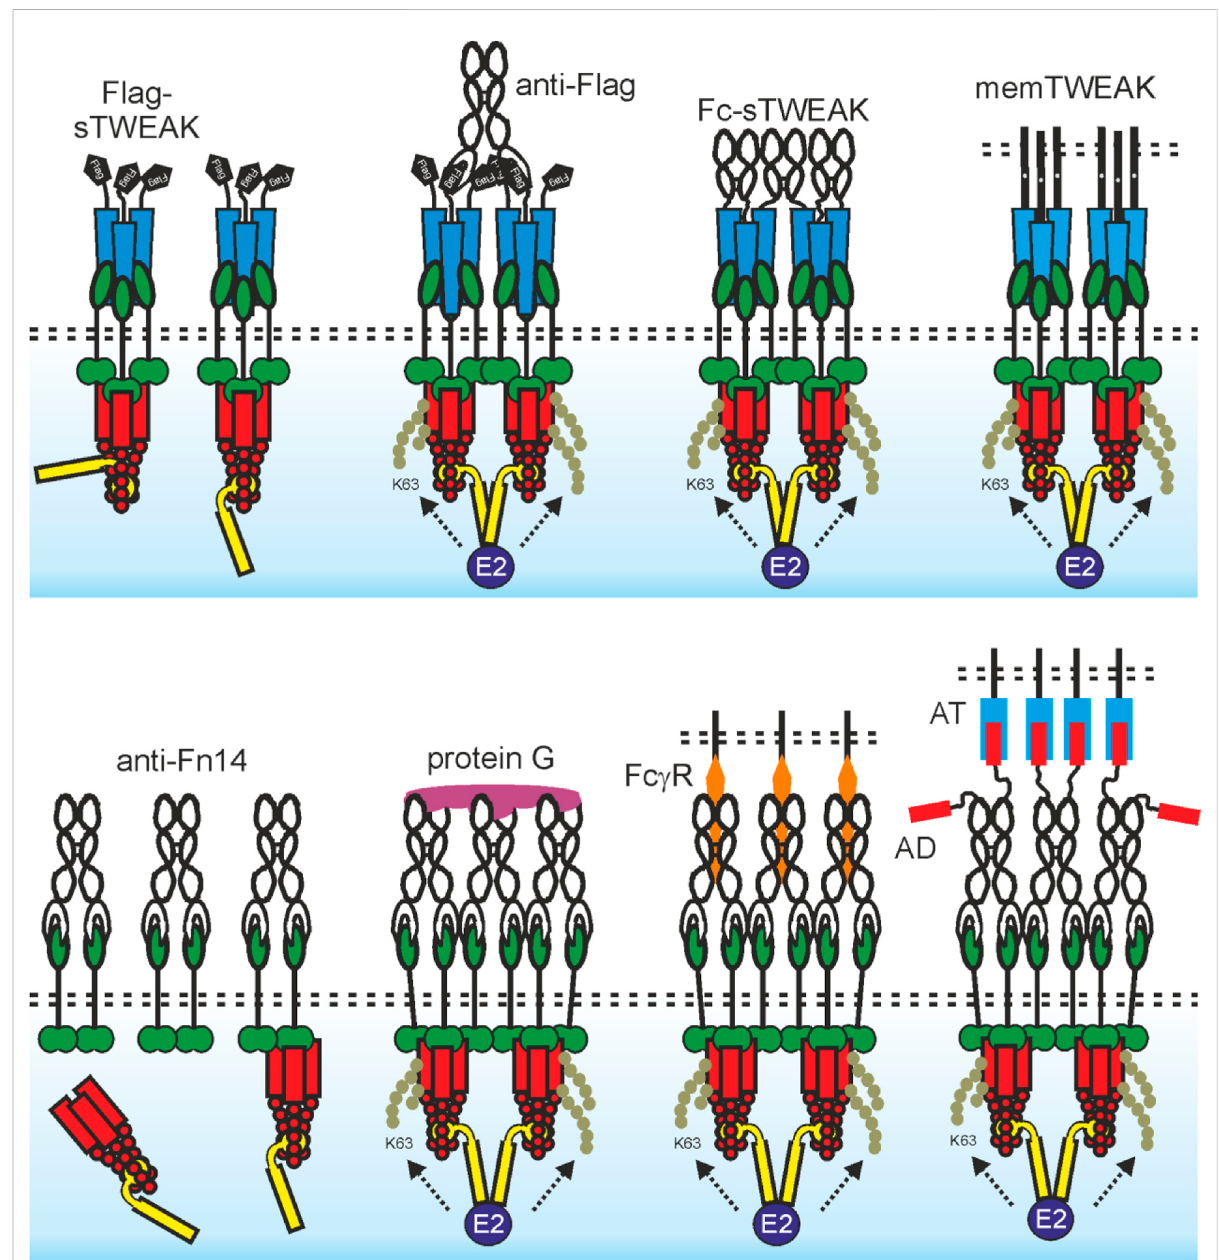
FIGURE 2 TheagonisticqualityofTWEAKtrimersandanti-Fn14antibodiesisdeterminedbyoligomerizationandmembrane-association.Upperpanel:An sTWEAK trimer recruits three Fn14molecules. The Fn14 trimers assembled by sTWEAK in turn recruit complexesof a TRAF2 trimer with one cIAP1 or cIAP2 molecule. This results inreduced availability of these molecules for other binding partners but does not trigger ef fi cient cIAP transactivation. If the proximity of two (or more) of these sTWEAK-associated Fn14 trimers is enforced, e.g., by use of antibody crosslinking (e.g., Flag-tagged sTWEAK with anti-Flag antibody) or by genetic fusionwith an oligomerization domain (e.g., Fc domain), this results in close neighborhood of two (or more) TRAF2-cIAP1/2 complexesand thus in cIAP transactivation and classical NF- κ B signaling (see also Figure 1).Due to thehigh concentrations of trimeric Fn14 complexes in the cell-to-cell contact zone with memTWEAK expressing cells, there is spontaneous clustering of the Fn14 complexes and again cIAP transactivation due to the tight neighborhood of TRAF2-cIAP1/2 complexes. Lower panel: An anti-Fn14 antibody recruits two Fn14molecules.Theanti-Fn14-boundFn14dimersrecruitoneTRAF2-cIAP1/2complexbutlessef fi cientthanansTWEAKtrimer.Thus,thereissome reduction in the cytosolic availability of TRAF2-cIAPs and therefore alternative NF- κ B signaling despite weaker as with sTWEAK (see upper panel and Figure 1). If the linkage of three (or more) of these anti-Fn14-associated Fn14 dimers is enforced, e.g. by protein G crosslinking this also induces neighborhood of several TRAF2-cIAP1/2 complexes and thus cIAP transactivation and classical NF- κ B signaling. Due to the high concentrations of dimericFn14complexesinthecell-to-cellcontactzonewithcellsdecoratedwithFc γ R-boundanti-Fn14antibodies(oranchoringtarget(AT)-bound anti-Fn14 antibody fusion proteins with an anchoring domain (AD), there is again spontaneous clustering of the Fn14 complexes and cIAP